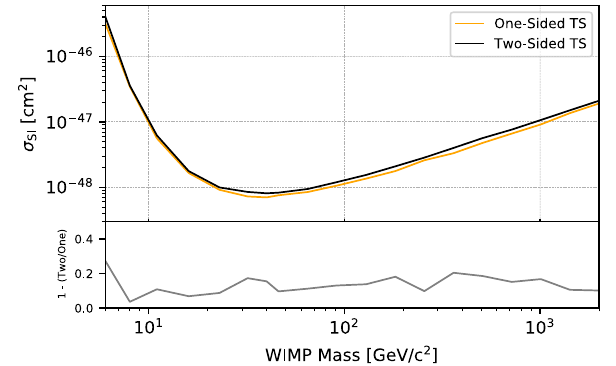
Fig. 2 Comparison of the upper limit obtained using a one-sided (orange) and a two-sided (black) test statistic, respectively, for the same data set. The relative difference is indicated in the lower panel, and for this study, it can can be as large as 20% for some masses